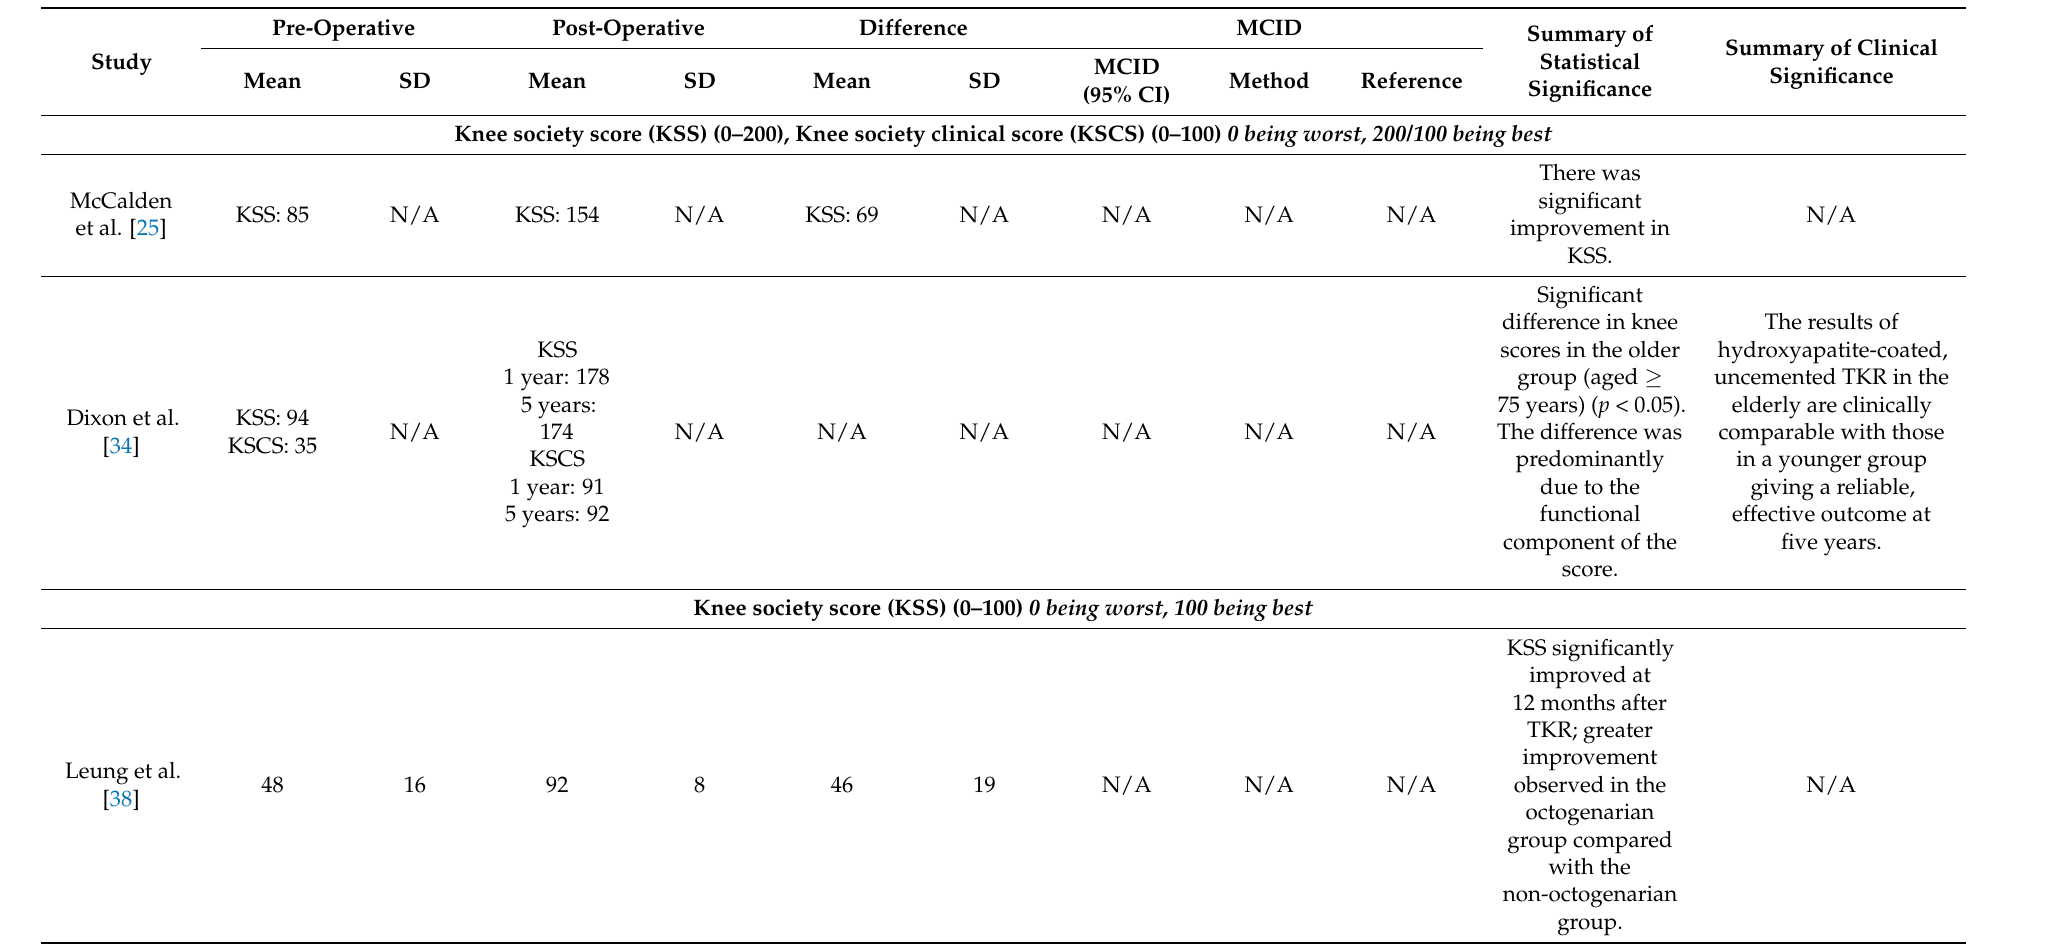
Table 4. Effect of total knee replacement on general knee